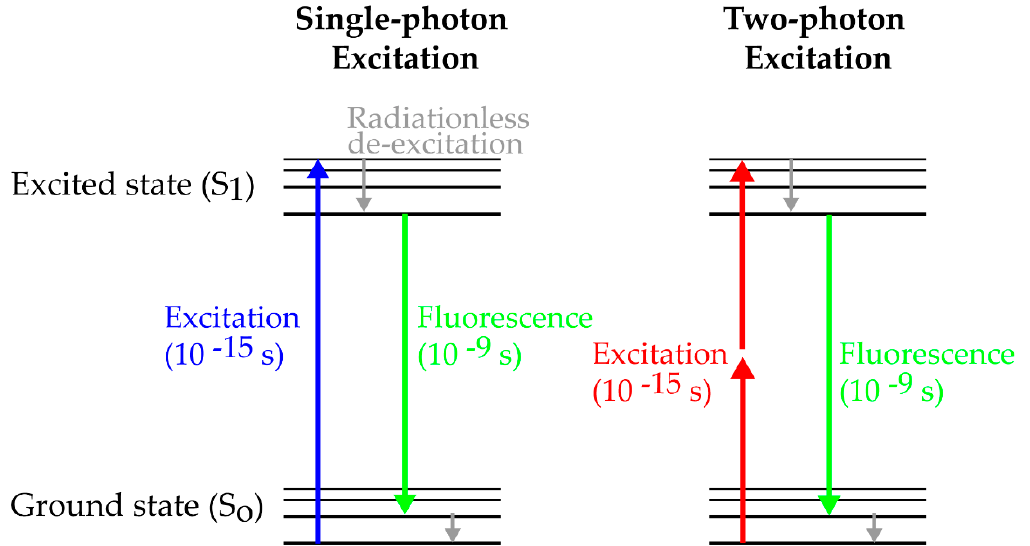
Figure 1. Simplified Perrin-Jablonski scheme for single-photon and two-photon excitation. Fluorophores reach the excited state after absorption of a single photon or of two photons within femtoseconds. After de-excitation and emission of fluorescence light, the molecule reaches the ground state within nanoseconds. Importantly, fluorescent emission is identical after single- and two-photon excitation.